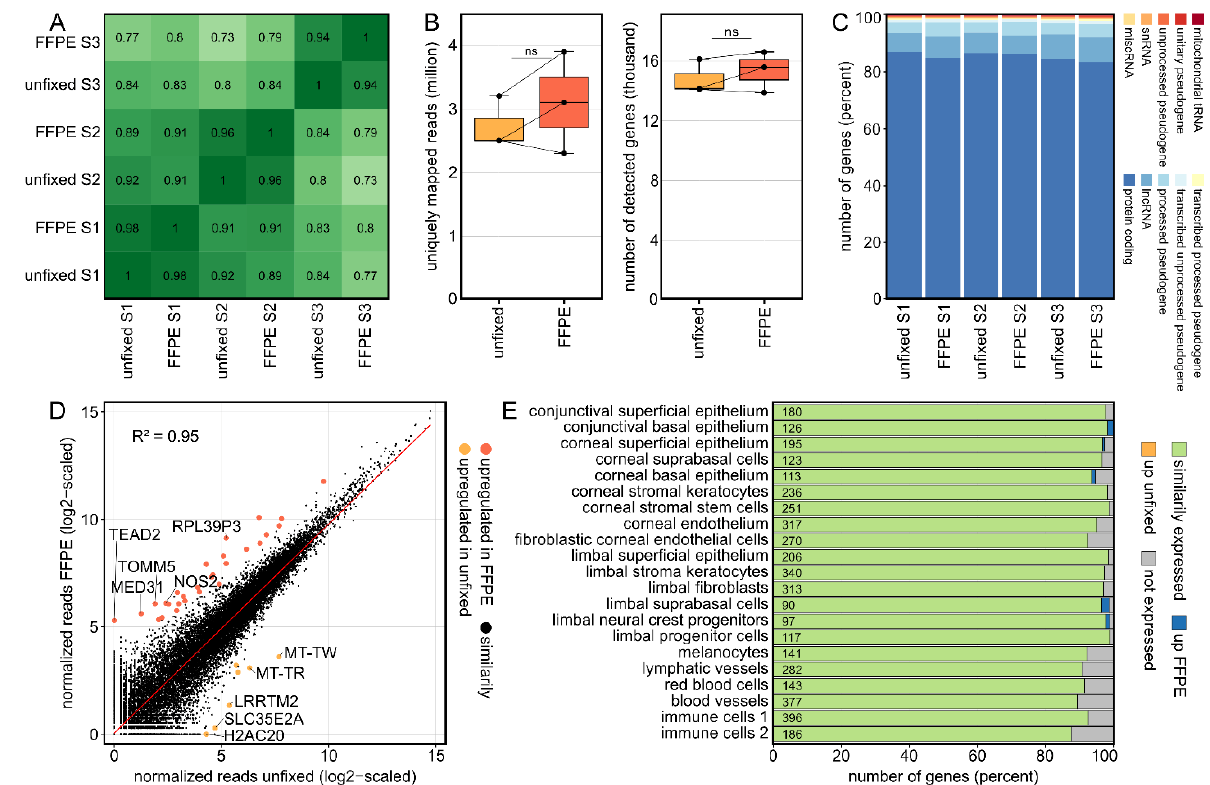
Figure 1. Formalin fixation does not have a significant impact on the transcriptional profile of human corneas. ( A ): The overall correlation coefficients between all analyzed samples revealed that the interindividual variability between the three corneas exceeded the influence of FFPE fixation, with correlation coefficients ranging from 0.94 to 0.98 between the fixed and unfixed corneal halves. FFPE: formalin fixation and paraffin embedding. ( B ): The number of uniquely mapped reads as well as the number of detected genes were comparable between fixed and unfixed corneas. The cross lines connect the respective divided sample pairs. ns: not significant. ( C ): Similarly, the proportion of different gene types such as protein coding genes or lncRNA was comparable between fixed and unfixed samples. lncRNA: long non-coding RNA; miscRNA: miscellaneous RNA; snRNA: small nuclear RNA; tRNA: transfer RNA. ( D ): Readplot visualizing differentially expressed genes (DEG) between fixed and unfixed samples. In total, there were 39,585 transcripts (99.91%) with similar expression between the two groups, with only 28 (0.07%) and 7 (0.02%) genes being up- and down-regulated by fixation, respectively. The overall squared correlation coefficient (R2) between fixed and unfixed samples was 0.95. The red line corresponds to the regression line. The top five DEG per group are labeled. ( E ): Impact of FFPE processing on the expression profile of corneal cell type-specific marker genes, as previously determined by single-cell RNA sequencing. The number of marker genes for each cell type is shown within the plot.